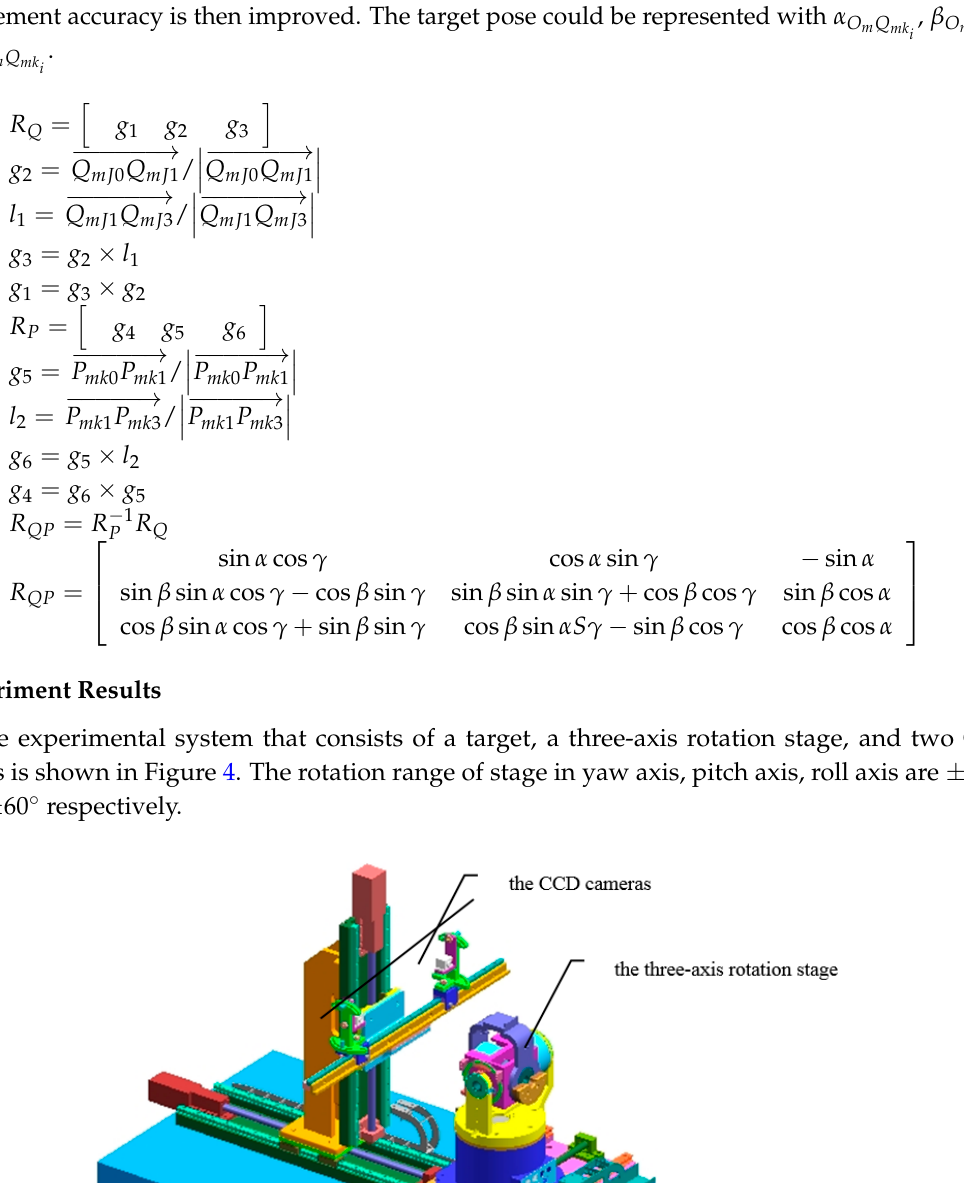
Table 1. Calibration results.